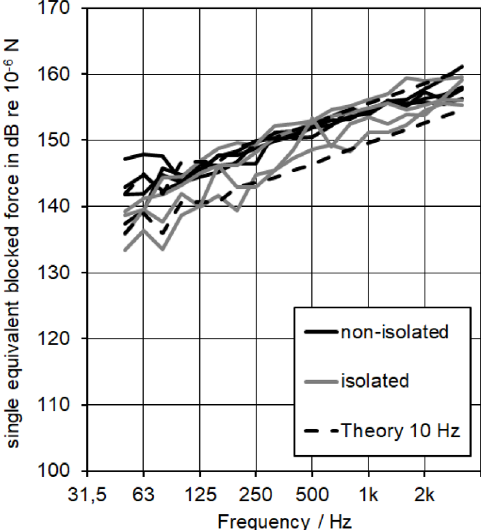
Figure 10. Single equivalent blocked force levels for the laboratory tapping machines LTM measured on isolated and non-isolated reception plates in comparison to the theoretical results for elastic and plastic impacts (Eq. (6) with T = 0.1 s).